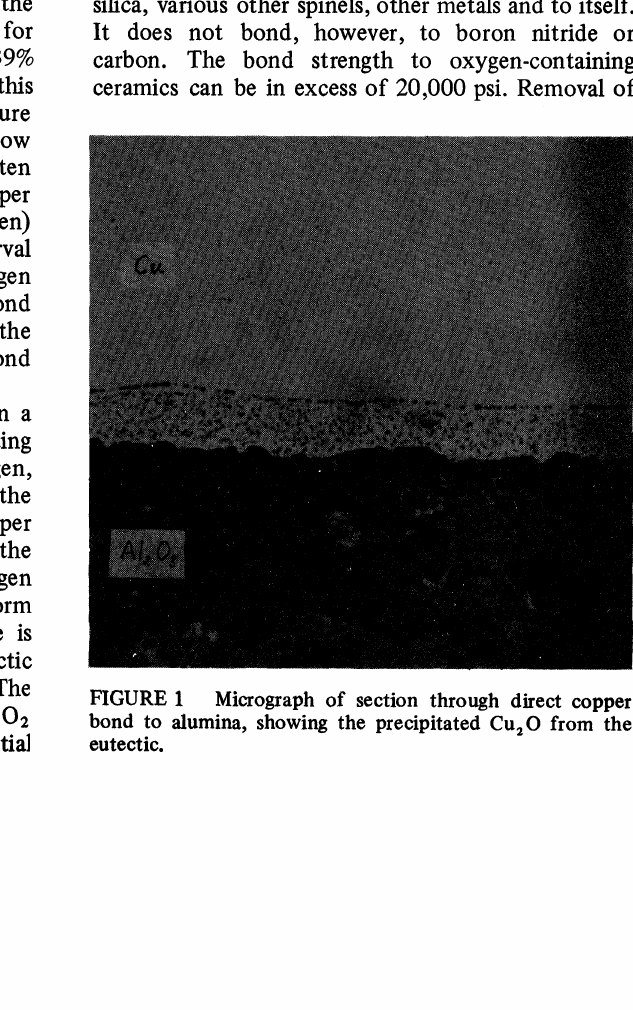
Mierograph of section through direct copper bond to alumina, showing the precipitated Cu 20 from the